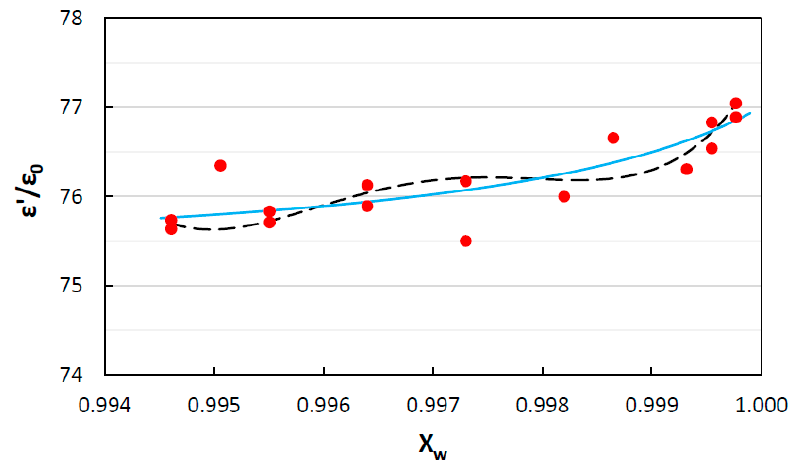
Figure 8. Measured values (•), Acree model curve (---), and King and Queen model curve ( − ) of 𝜀 (cid:4593) /𝜀 (cid:2868) 𝜀 (cid:4593)(cid:4593) /𝜀 (cid:2868) for the water–NaCl mixtures, reported as a function of the water molar fraction ( x w ).